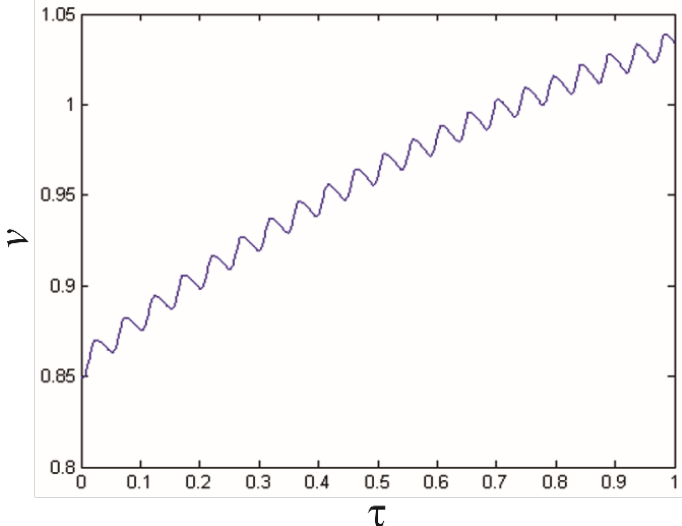
Figure 9. The evolution of the v ( τ ) concentration at high flux (α = 3000/9; β = 6/23; C = 0.001; A = 0.14 mol; M = 0.3 mol; H = 0.26 mol and k f = 6.18 × 10 −4 ) and initial values: x (0) = 0.045; z (0) = 0.9; v (0) = 0.85.